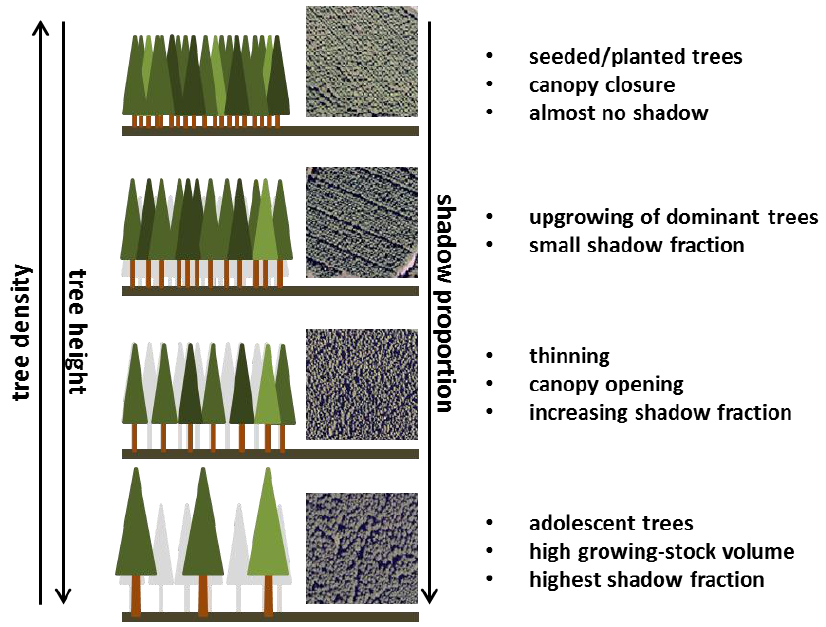
Figure 13. Structural differences and their appearance in aerial photos during the development stages of Norway spruce forest